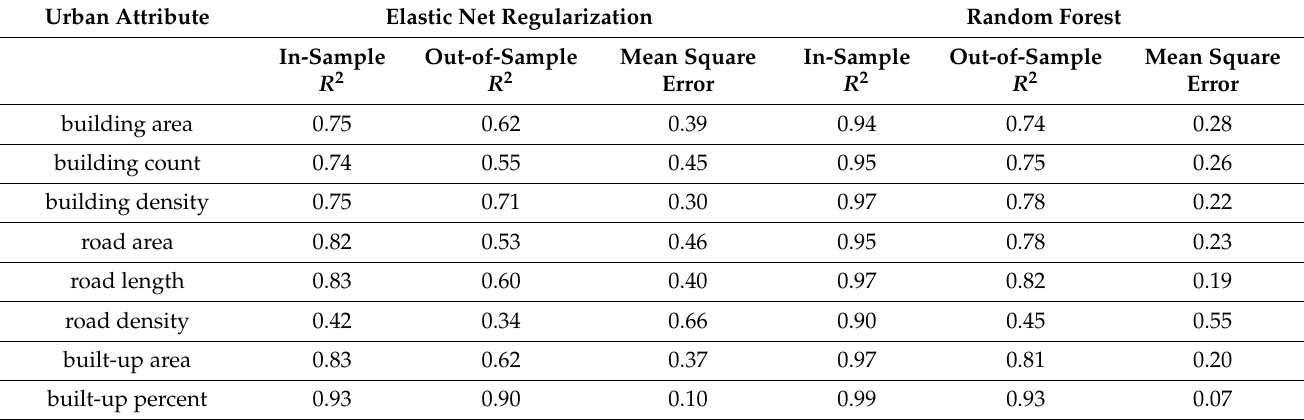
Table 11. R 2 and mean square error values for urban attributes using elastic net regularization and random forest models with Sentinel-2 imagery for Accra (314 Enumeration Areas), Belize (80 Enumeration Districts), and Sri Lanka (333 Grama Niladhari Divisions) combined.